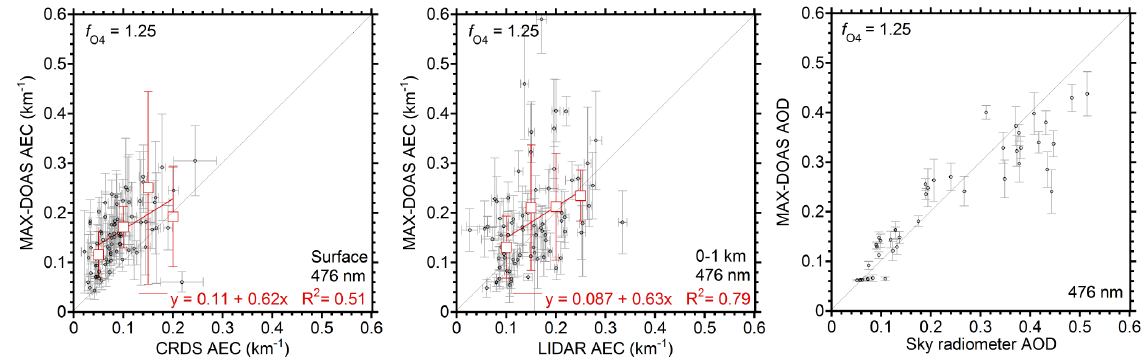
Figure 5. Correlation plots (left) between near-surface AEC values from CRDS and MAX-DOAS, (center) between mean AEC values for 0–1km from lidar and MAX-DOAS, and (right) between AOD values from sky radiometer and MAX-DOAS. In AEC plots, red symbols show the averages of the MAX-DOAS AEC values for each 0.05km − 1 bin of CRDS or lidar data. The bin has been optimized considering the number of bins and the number of data in each bin for all pairs of comparisons in this study. For the MAX-DOAS retrieval, a f O is assumed.